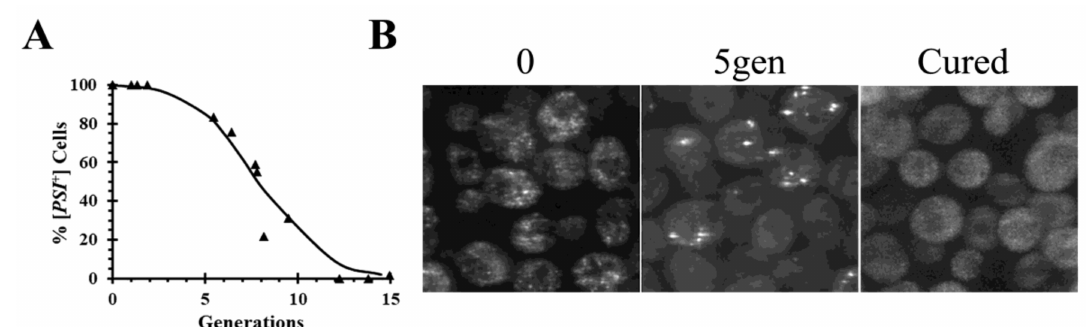
Figure 1. Curing of [ PSI + ] in SY80 yeast strain by overexpression of dominant negative Hsp104 mutant. ( A ) Time course of curing [ PSI + ] as a function of generation time. ( B ) Images of the green fluorescent labeled (GFP)-labeled foci in SY80 yeast strain before induction, after 5 generations in galactose medium to induce expression of the dominant negative mutant, and completely cured. SY80 strain contains a relatively strong [ PSI + ] variant, which was engineered to express GFP-labeled Sup35 from the SUP35 chromosomal locus